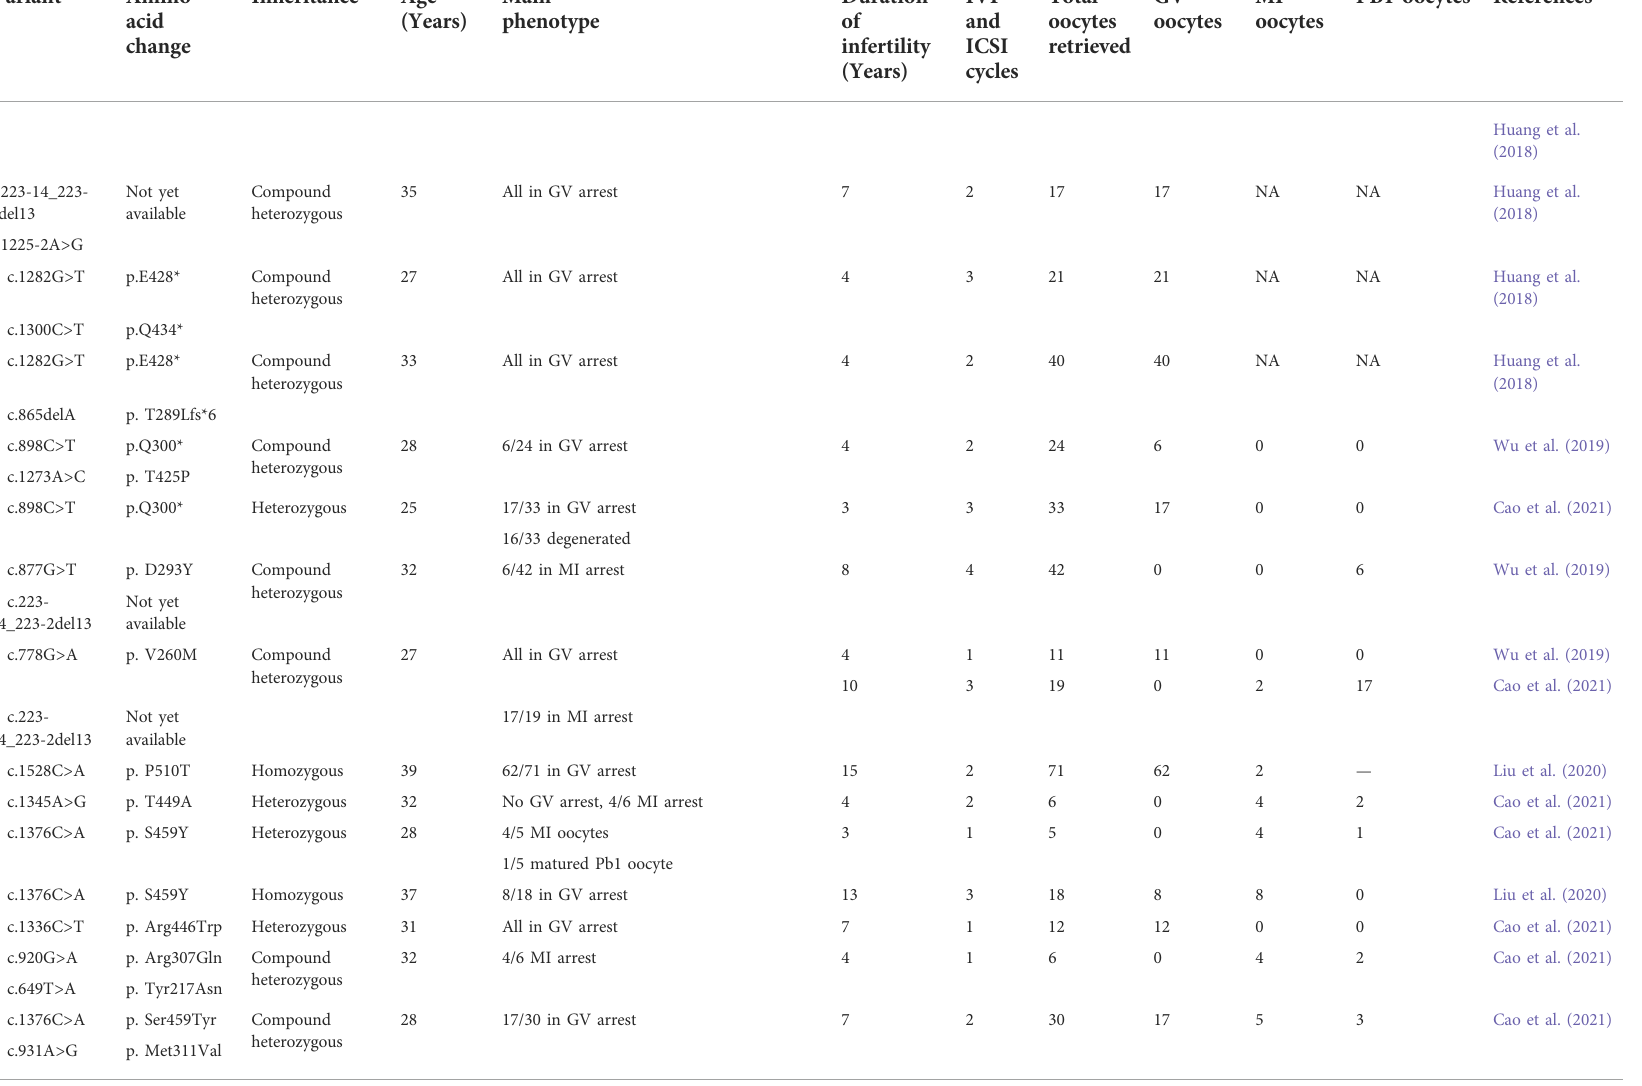
TABLE 2 ( Continued ) Characteristics of patients with PATL2 variants and results of IVF